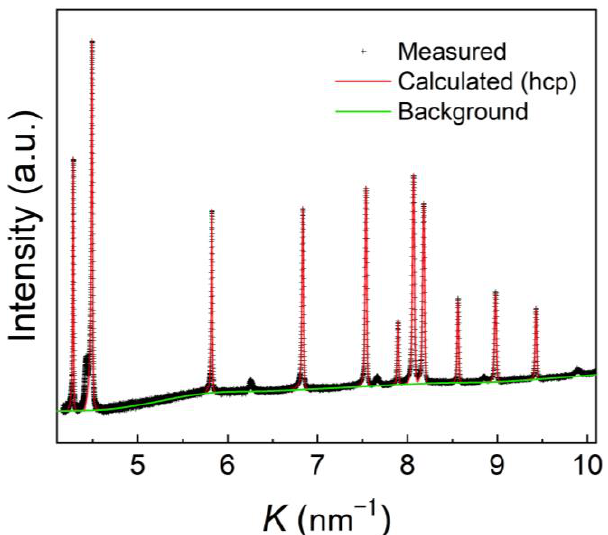
Figure 4. An example of the fitting result for the TOF-ND pattern of the as-built specimen using the CMWP method.